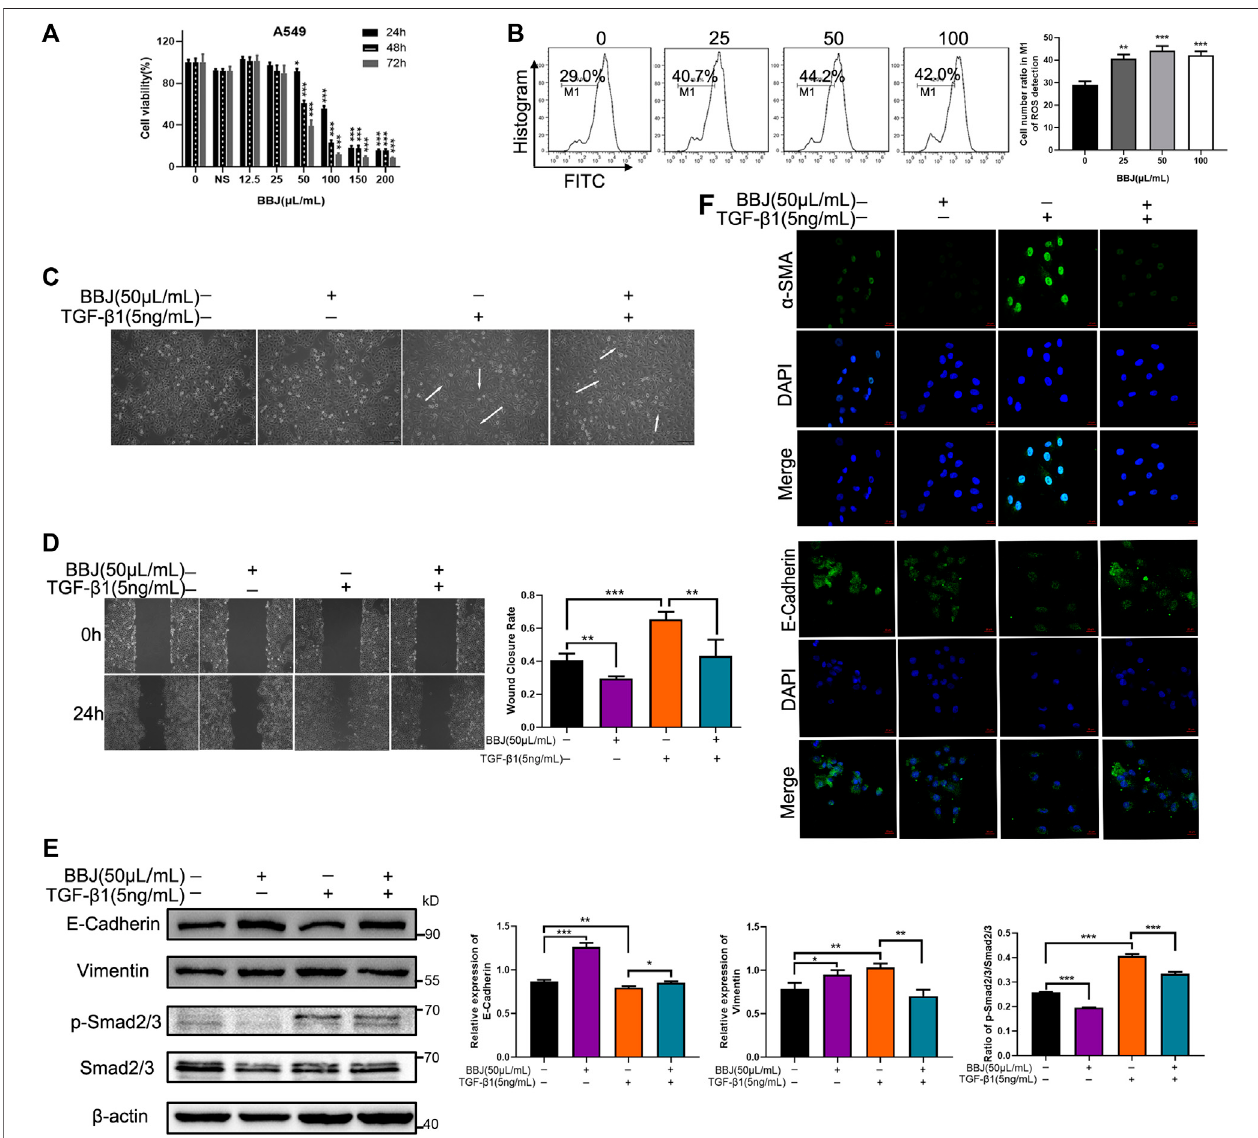
FIGURE 4 | BBJ could reverse EMT progress in A549. (A) The cytotoxicity of BBJ on A549 was determined by an MTT test. A549 cells were treated with different doses of BBJ and 200 μ l/ml normal saline for 24, 48, and 72 h. Datawere presented as mean ± SD from three experiments. (B) ROS of A549 treated with BBJ for 24 h were detected by fl ow cytometry and counted. (C) After starvation for 6 h with serum-free medium, fresh medium with 5 ng/ml TGF- β 1 was replaced. One hour later, 50 μ l/ml BBJ was added. After 24 h, cell morphology of A549 was observed by a microscope (×10). (D) A549 cells were seeded in six-well plates for 24 h and starved for 6 h with serum-free medium. Then, a scratch was made by 100 μ l pipette tips, and fresh medium with 5 ng/ml TGF- β 1 was added. One hour later, 50 μ l/ml BBJ was added. The scratches were photographed at 0 and 24 h by an inverted microscope (×10). The scratch areas were treated statistically by ImageJ. (E) After incubation with 5 ng/ml TGF- β 1 for 1 h and 50 μ l/ml BBJ for an extra 24 h, expressions of E-cadherin, vimentin, p-Smad2/3, Smad2/3, and β -actin in A549 were analyzedbywesternblotting. (F) AfterstimulationbyTGF- β 1for1 handtreatmentwithBBJfor24 h,expressionsof α -SMAandE-cadherinwerevisualizedbyaconfocal fl uorescence microscope (×40). * p < 0.05; ** p < 0.01; *** p < 0.001 versus the control group or TGF- β 1 group.